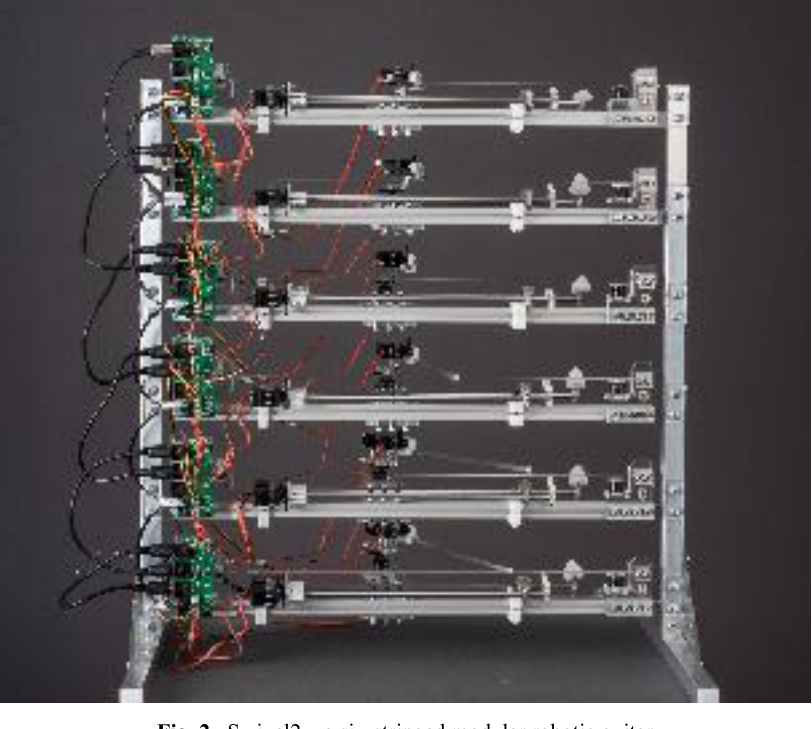
Fig. 2. Swivel2 – a six-stringed modular robotic guitar